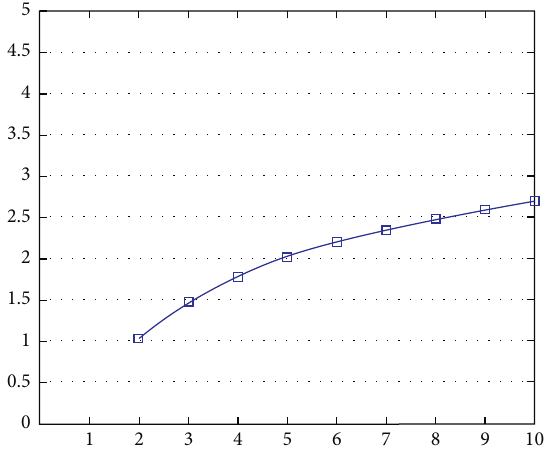
Figure 15: GA entropy of HDN2 ( n )